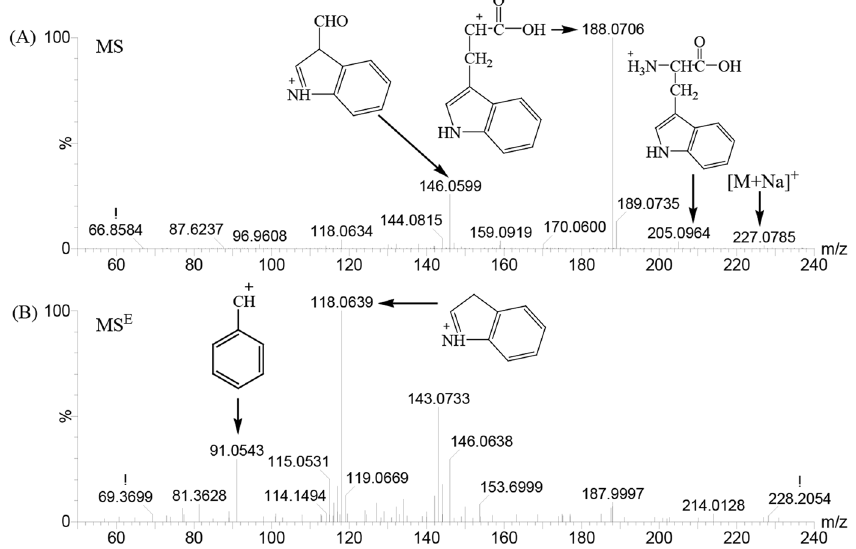
Figure 7. MS ( A ) and MS E ( B ) of biomarker- tryptophan at m/z 188.0706 in the positive ion mode.